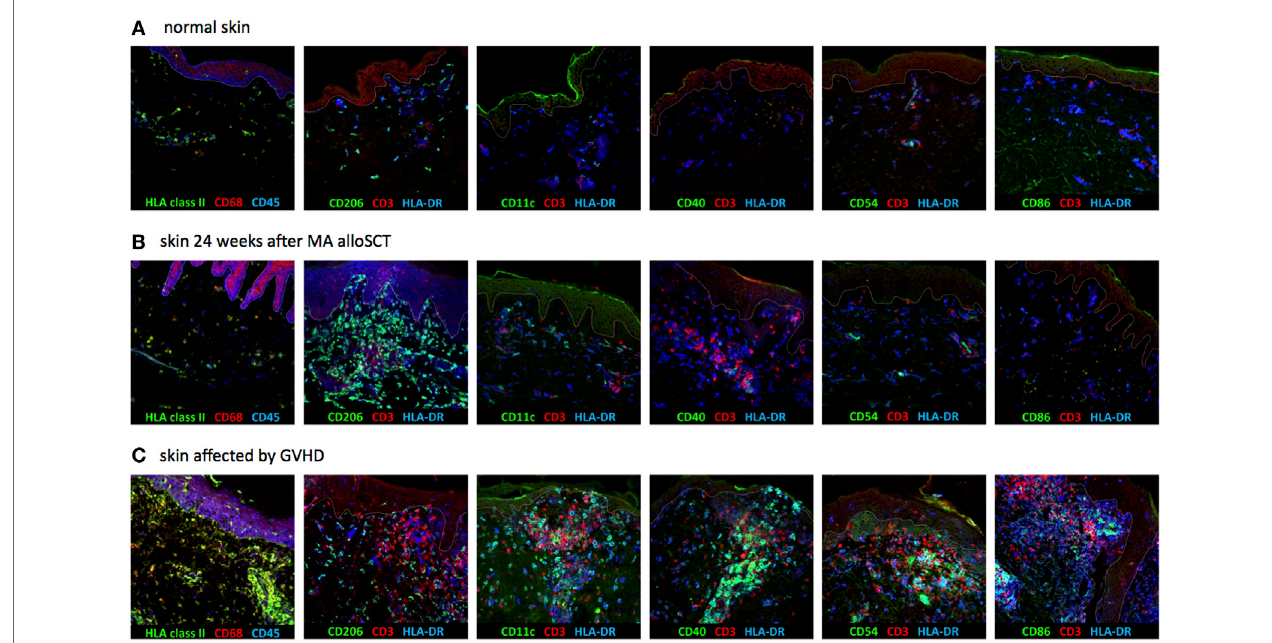
FigUre 4 | Dermal HLA class II-expressing cells seen after myeloablative (MA) allogeneic stem cell transplantation (alloSCT) were macrophages with non-professional antigen-presenting cell (APC) phenotype. (a) In normal skin, the majority of HLA class II-expressing cells were macrophages, as indicated by the expression of CD68 and CD206, while also some resident dermal dendritic cells (CD11c positive) were detected. The HLA class II-expressing cells were negative for CD40, CD54, and CD86. (B) Skin biopsies taken from patients in which an increase in HLA class II-positive cells was observed after MA alloSCT. HLA class II-expressing cells were CD68- and CD206-positive macrophages from which only a few expressed also CD11c. There was no expression of CD40, CD54, or CD86, so the HLA class II-expressing cells did not have the characteristics of activated professional APC. (c) Skin biopsies from skin affected by acute graft-versus-host disease (GVHD) showed increase in HLA class II-expressing cells with professional inflammatory APC phenotype (CD11c, CD40, CD54, and CD86 positive, while CD206 is negative). White line demarks the border between dermis and